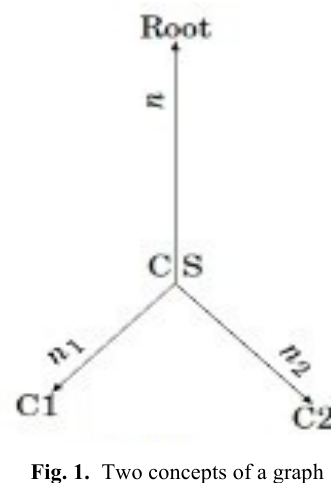
Fig. 1. Two concepts of a